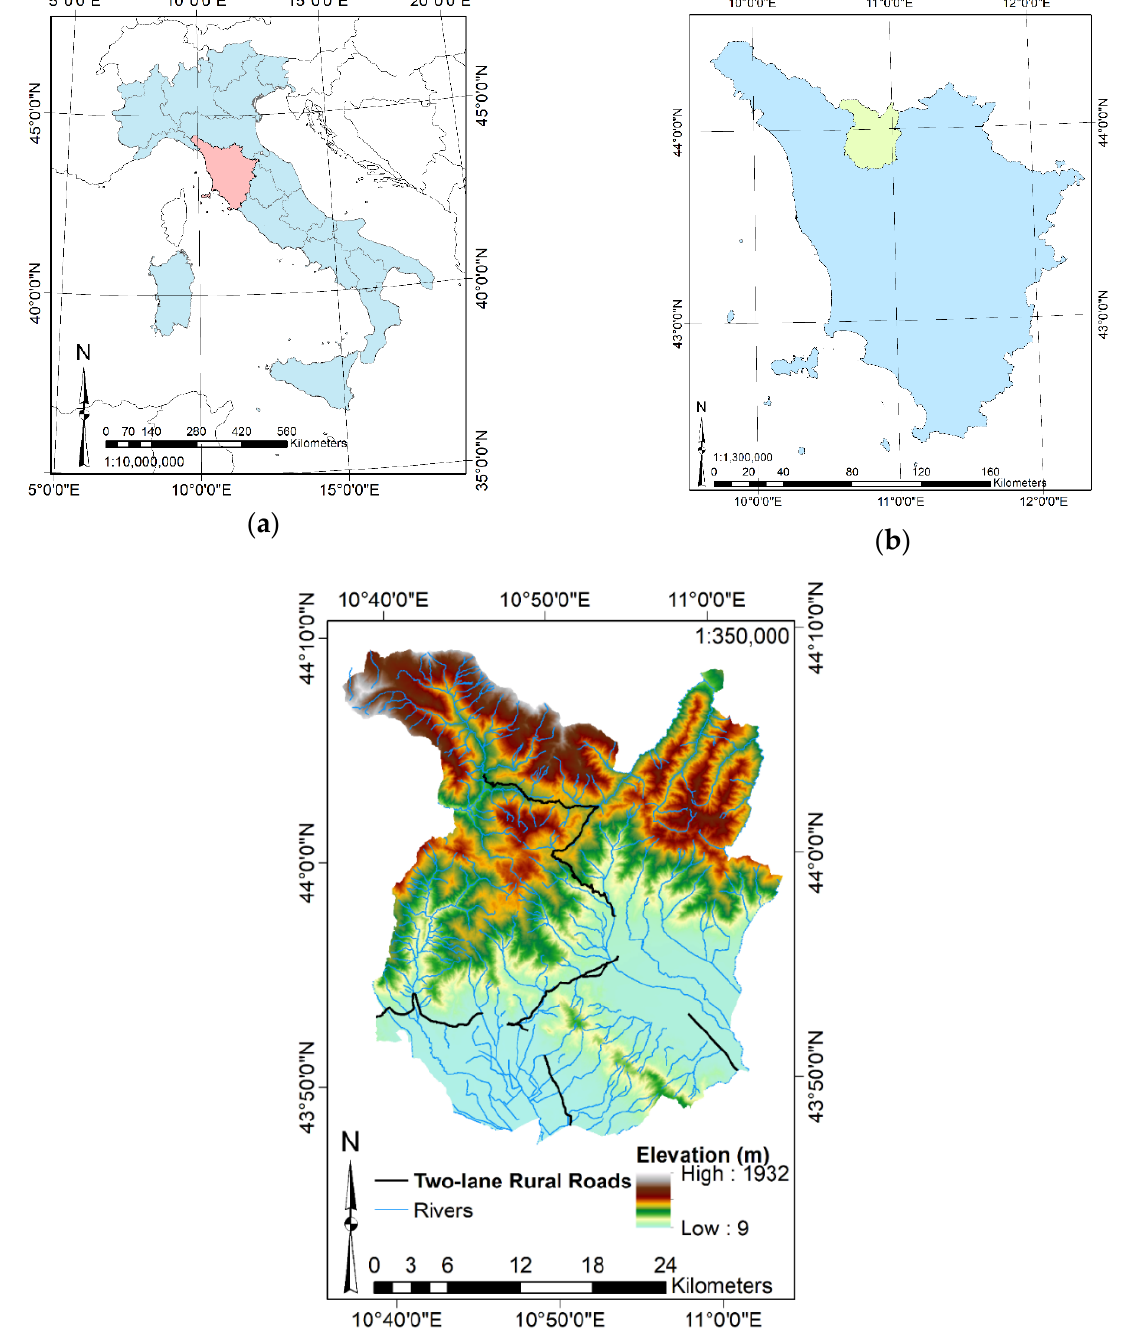
Figure 1. Study area: ( a ) Italy (light blue) and the Tuscany Region (pink); ( b ) Tuscany Region (light blue) and the Province of Pistoia (light green); ( c ) Study area: elevation, river network, and two-lane rural roads crossing the area.